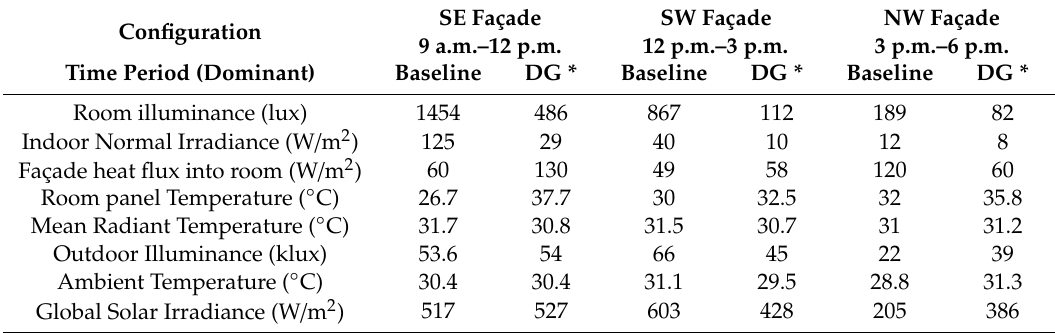
Table 5. Average (Indoor Environment Quality) IEQ measured during direct sunshine periods for di ff erent